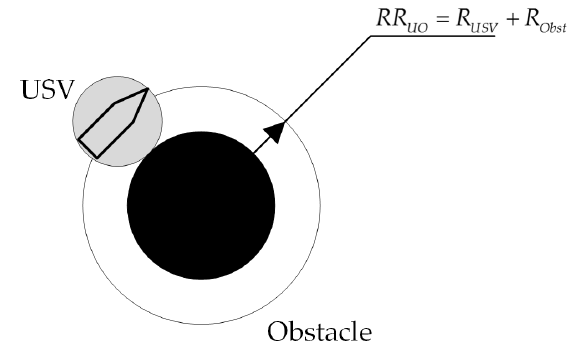
Figure 8. The expanded obstacle.